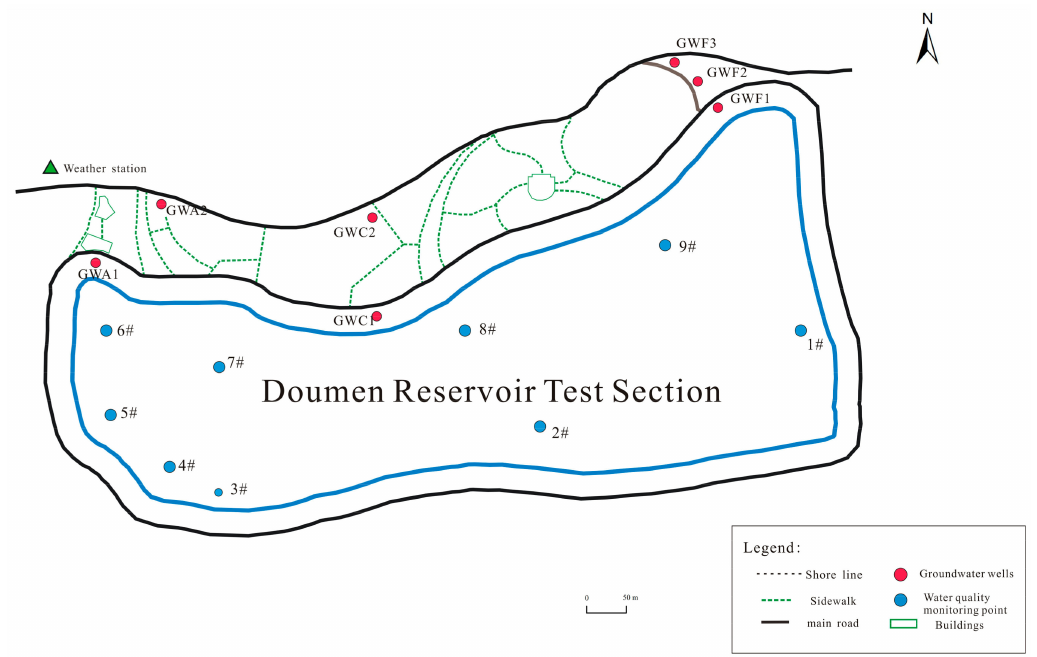
Figure 2. Schematic diagram of monitoring distribution of surface water and groundwater in the Doumen Reservoir Test Section